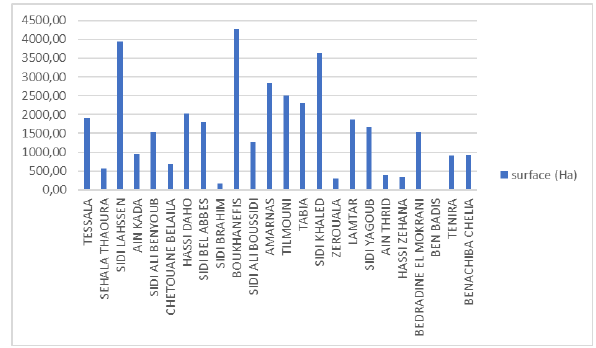
Figure 9 . Graphical representation of the results